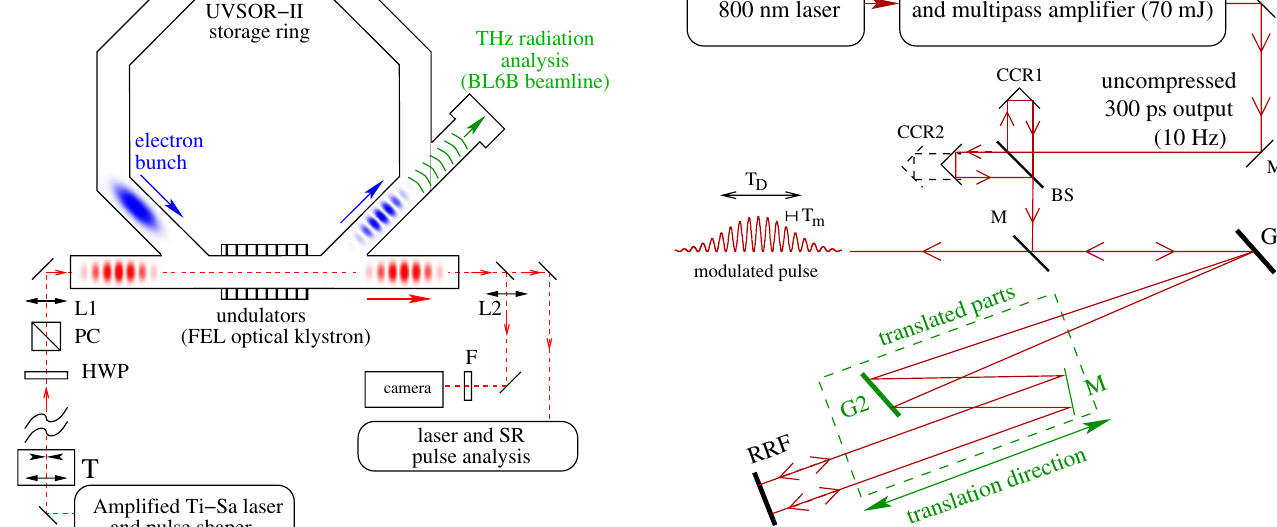
FIG. 2. Global organization of the experiment at the UVSOR- II storage ring. We produce long laser pulses with an adjustable duration and a sinusoidal intensity modulation. The period is adjustable in the cm-submillimeter range, and the duration is typically chosen from few ps to 190 ps (FWHM). The laser pulses interact with the electron bunch inside an undulator (FEL beam line) and produce an energy modulation. The transport through magnetic elements (in particular dipoles) converts this energy modulation into a charge density modulation, and nar- rowband CSR terahertz emission is produced at bending magnet beam lines. CSR emission is monitored at the BL6B beam line. T: 0 : 5 (cid:4) telescope; HWP: half-wave plate; PC: polarizing cube;